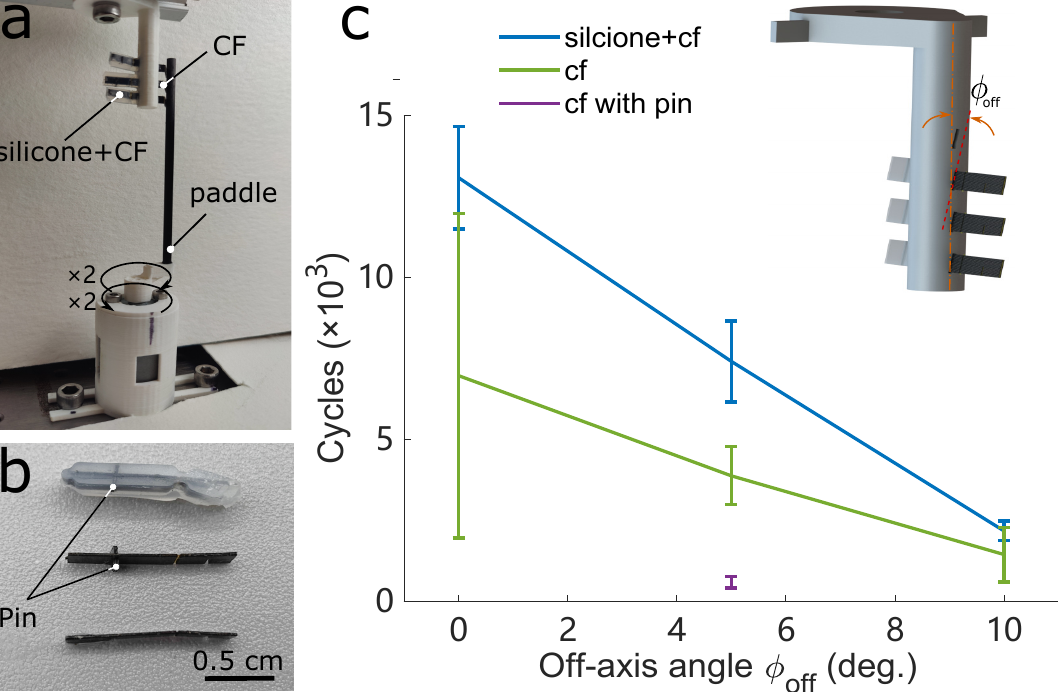
(deg.) off Figure 10. Comparison of the fatigue resistance between different transmission hinge. ( a ) Experi- ment setup for testing the fatigue of different transmission hinges. ( b ) Different transmission hinges. Silicone + CF (with pin), CF (with pin) and CF (without pin) transmission hinges. ( c ) The blue line indicates the transmission hinge with silicone + CF has a higher life cycle period than the CF hinge and much higher than the CF with pin (which is the same pin on the transmission hinge with silicone +